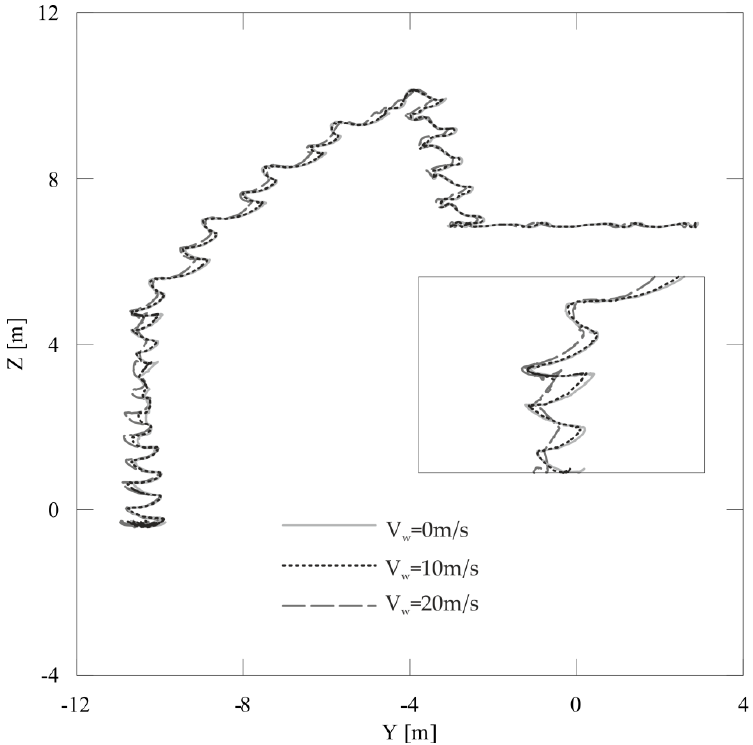
Figure 24. Trajectory projections of the carried load’s center of mass in one of the lifting planes (wind power having impact according to the direction of the Y axis).